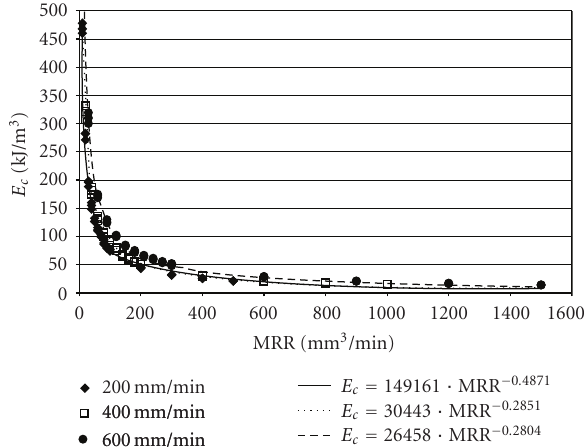
Figure 6: Comparison among model and experimental data of E c versus MRR and v a .